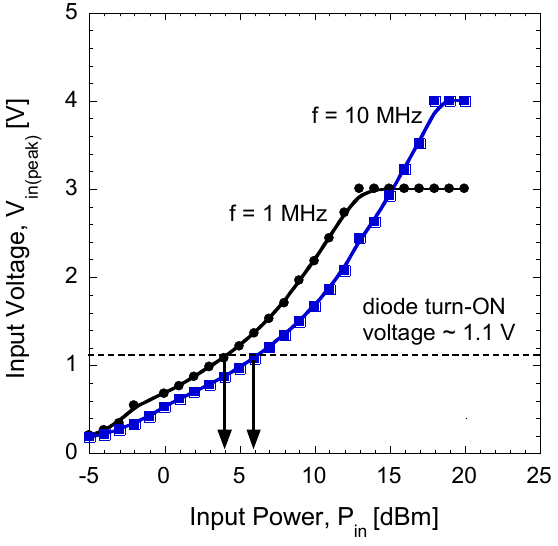
Figure 3. Generated input voltages as a function of injection